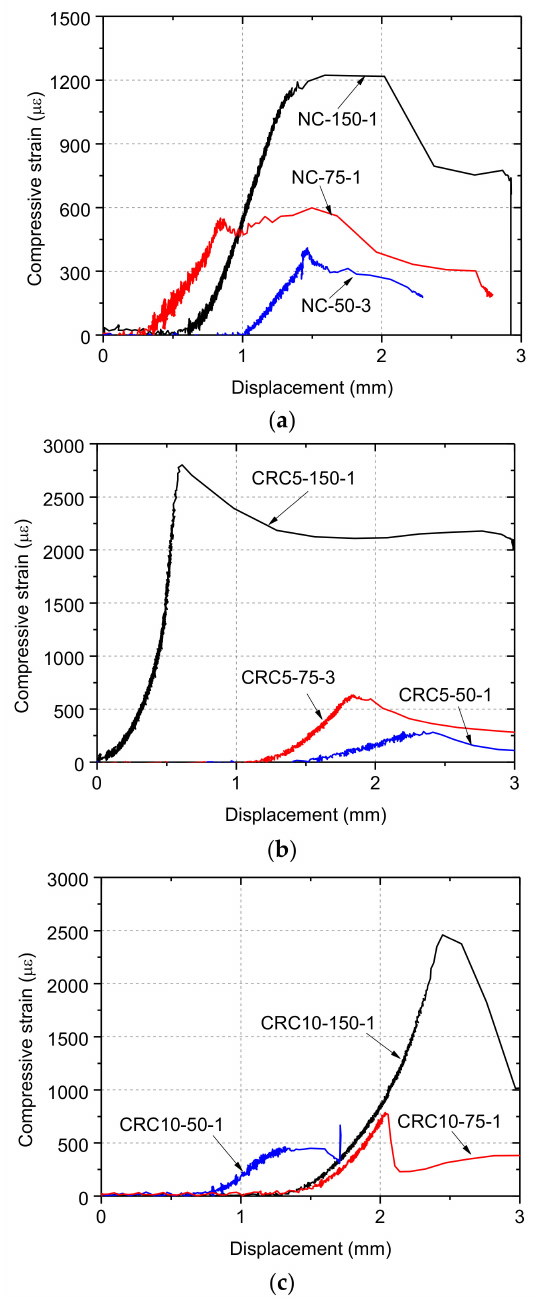
Figure 13. Displacement results: ( a ) NC; ( b ) CRC5; ( c )